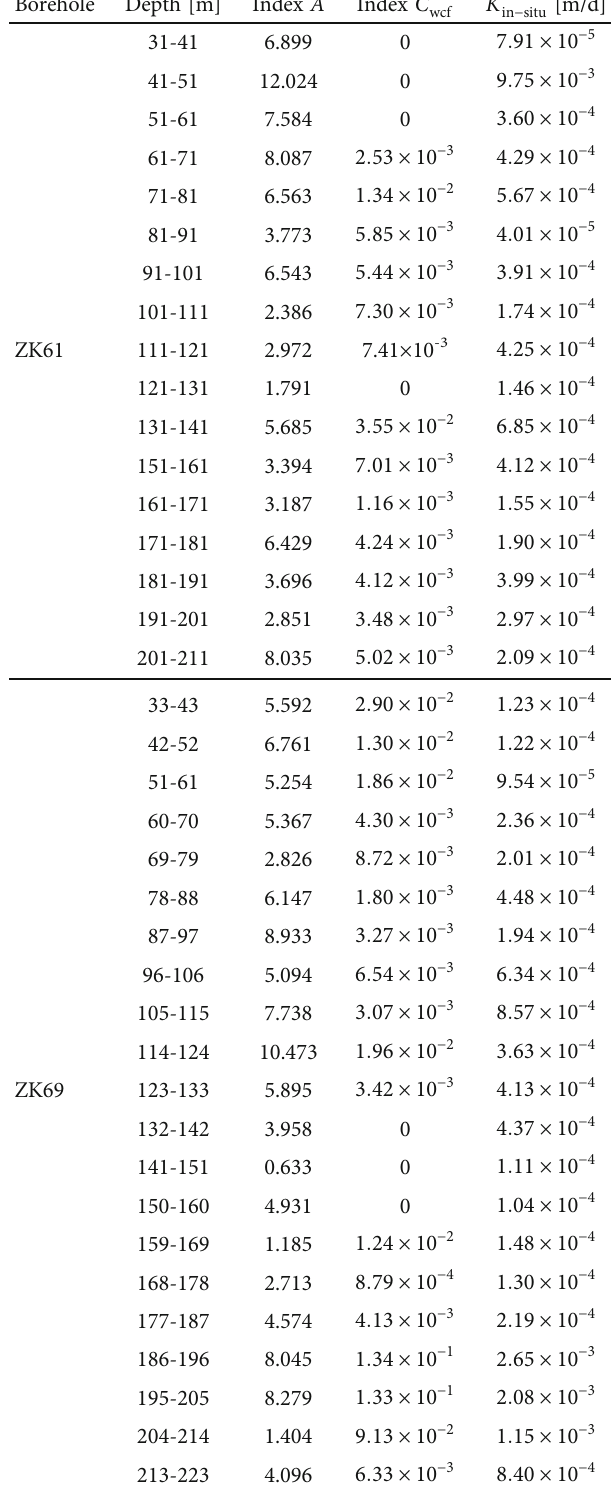
Table 1: Test results of boreholes in the study